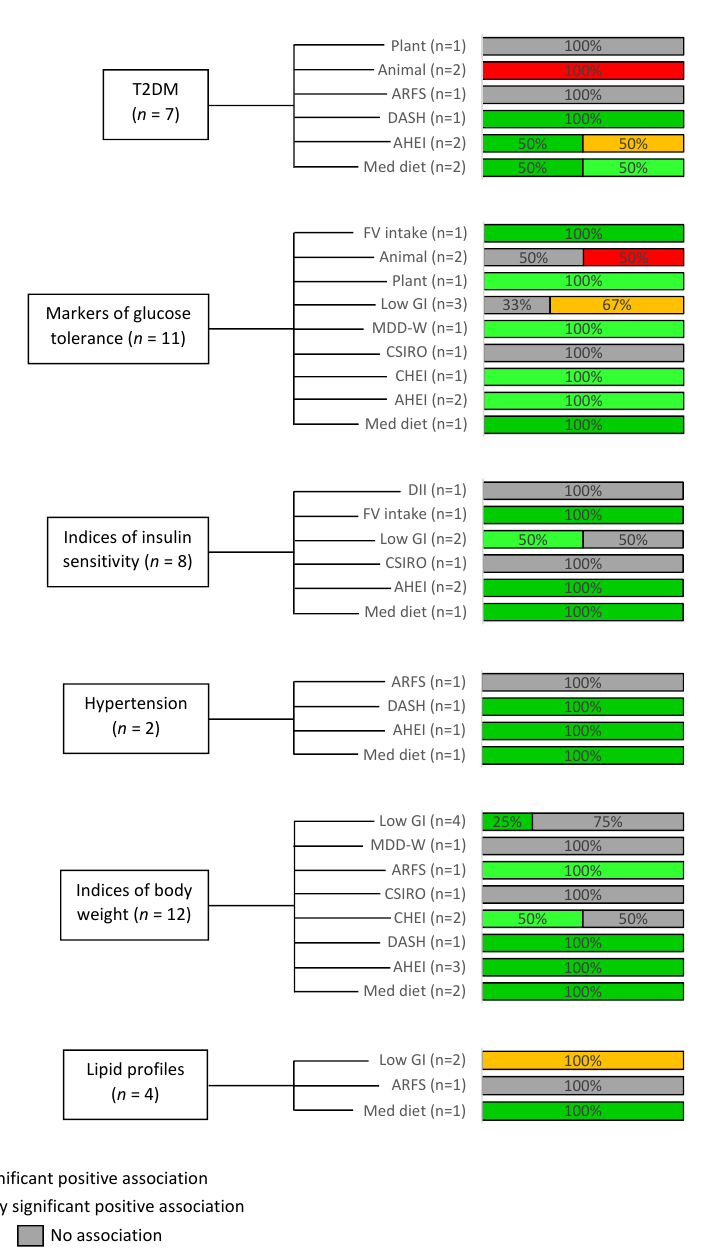
Figure 2. Overview of outcomes reported within included studies and the proportion of studies evaluating these outcomes which demonstrated an association with specified dietary patterns. Markers of glucose tolerance’ includes fasting plasma glucose, 2-h post-glucose load glucose levels, and HbA1c which were variously reported and combined to allow for the determination of overall patterns. Similarly, ‘indices of insulin sensitivity’ includes Matsuda index and HOMA-IR. ‘Indices of body weight’ including BMI, body fat, and waist/hip ratio were similarly clustered, and variously reported lipid parameters were also collated to allow comparison. A positive association refers to a desired outcome i.e., improved glucose tolerance and reduced incidence of hypertension. Plant: low-carbohydrate diet with higher proportion of macronutrients from plant sources, Animal: low-carbohydrate diet with higher proportion of macronutrients from animal sources, AHEI: Alternate Healthy Eating Index, Med Diet: Mediterranean Diet, DASH: Dietary Approaches to Stop Hypertension, Chinese